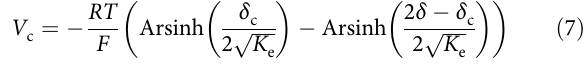
(Supplementary Table 1) by using the apparatus and method shown in Supplementary Figs. 2, 3. The details can be found in the Supplementary Methods. The maximum V c value for all samples is only 0.11 V (Fig. 2b). Such small values are consistent